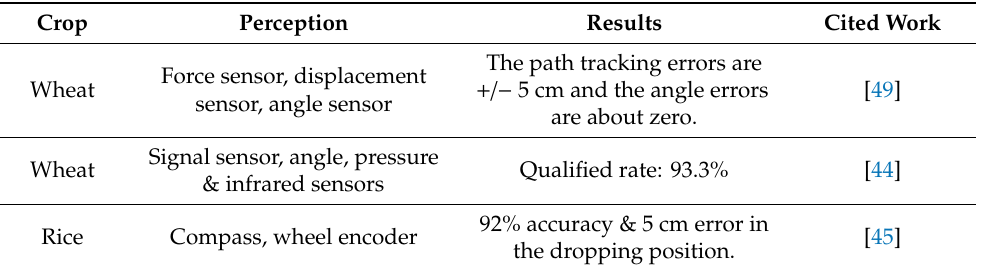
Table 2. Seeding agrirobotic systems’ characteristics for wheat and rice. Crop Perception The path tracking errors are +/ − 5 cm and the angle errors are about